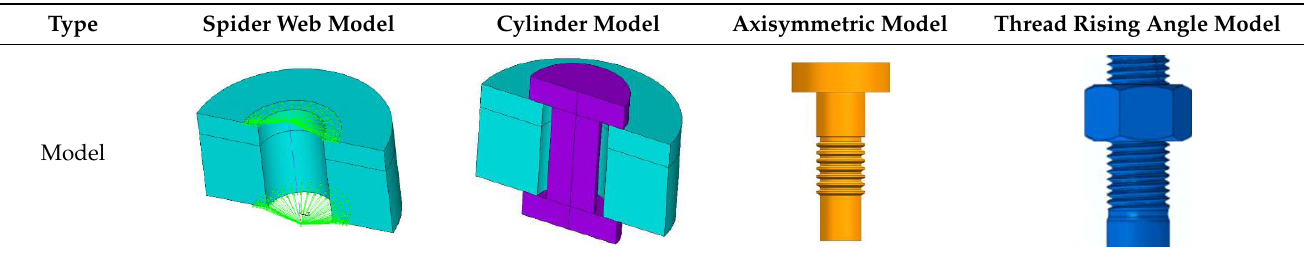
Table 1. The types of finite element modeling of full-size bolts.